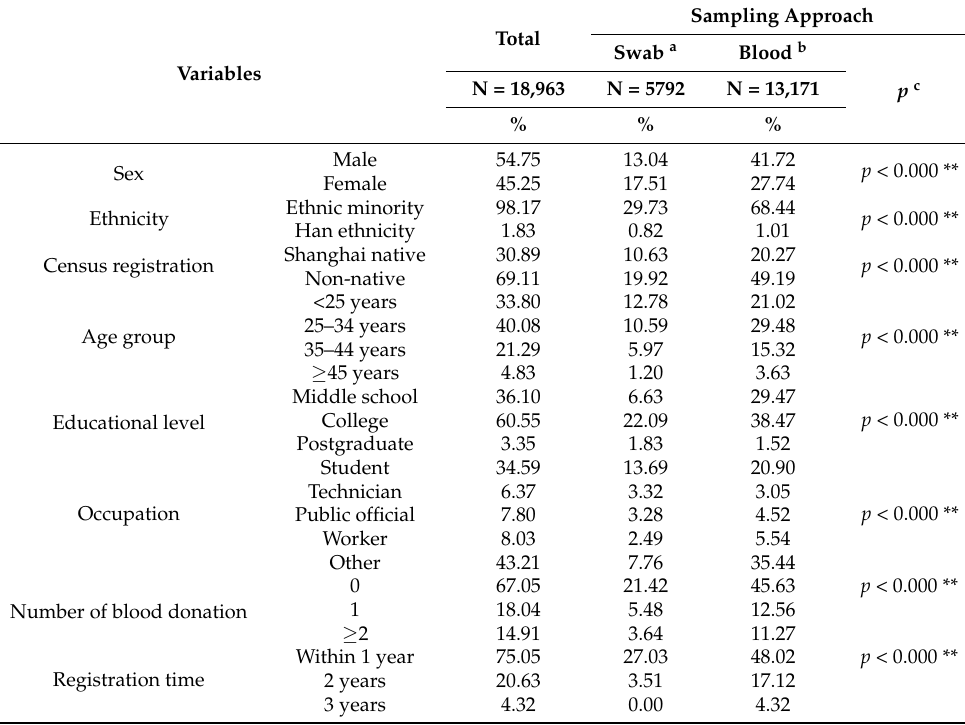
Table 1. General population characteristics of the hematopoietic stem cell donation (HSCD) volun- teers according to sampling approach.